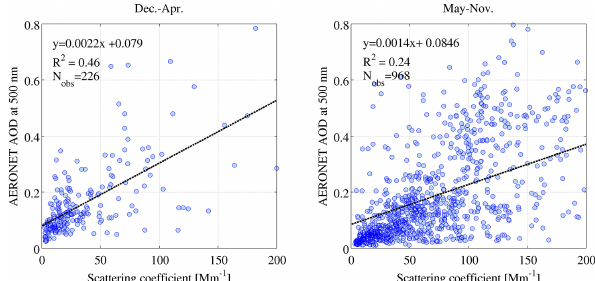
Figure 4. Comparison between AOD at 500nm available from AERONET (see text) and in situ scattering coefficients measured at the Elandsfontein station. The AOD is the column-integrated value of aerosol extinction (scattering + absorption) obtained from sun- photometer measurements. The in situ scattering coefficient is mea- sured with a nephelometer.